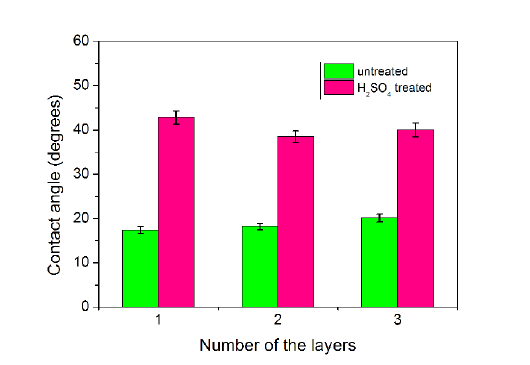
Figure 3. Water contact angle on untreated and sulfuric acid treated DMSO-doped PEDOT:PSS films. Each column of the histogram is plotted with error bar representing the standard deviation